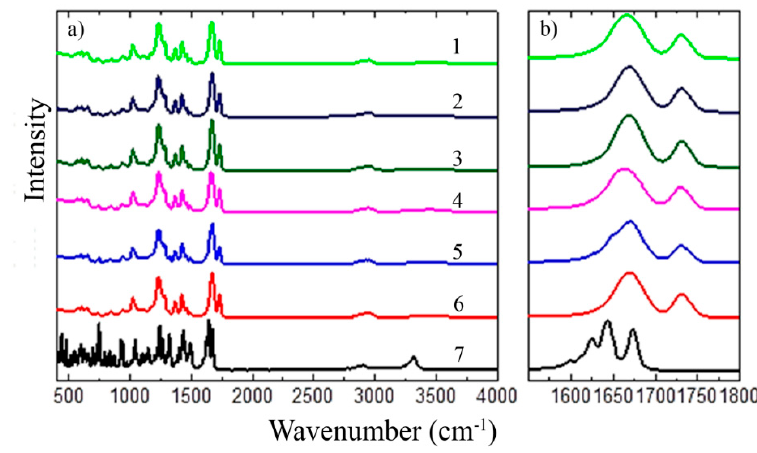
Figure 4. FT-IR spectra of pure TAD, K64, their PM and SDs: ( a ) 1 —TAD-K64 SD (HME250), 2 —TAD-K64 SD (HME125), 3 —TAD-K64 SD (SPD), 4 —TAD-K64 SD (SE), 5 —TAD-K64 PM, 6 —pure K64, 7 —pure TAD and ( b ) their detail spectra at 1600–1800 cm − 1 .